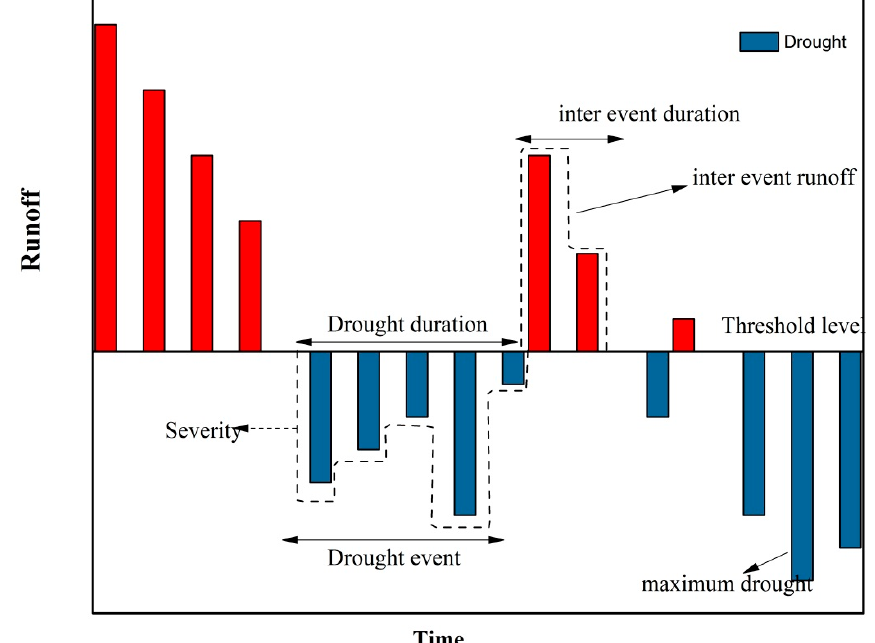
Figure 5. Sketch of methodology for threshold levels for hydrological regime.